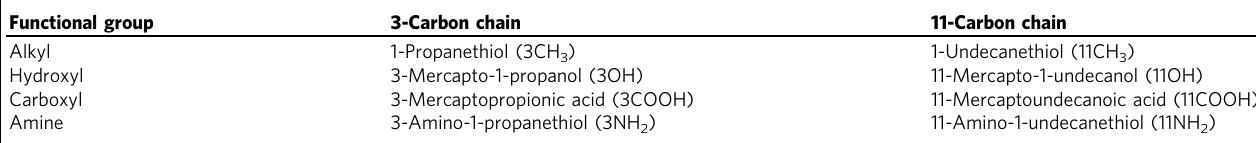
Table 1 Self-assembled monolayer (SAM) forming molecules used in FASERS fabrication. Functional